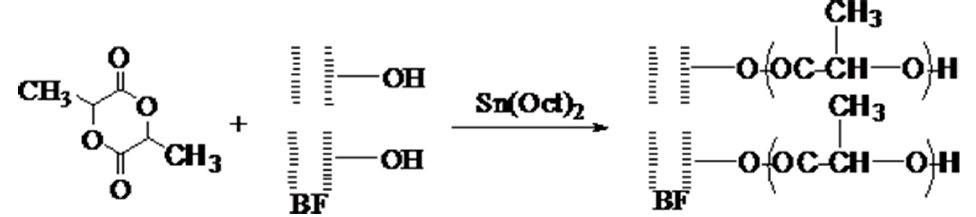
Figure 3. Reaction mechanism for Bamboo flour (BF) grafting lactide (LA).